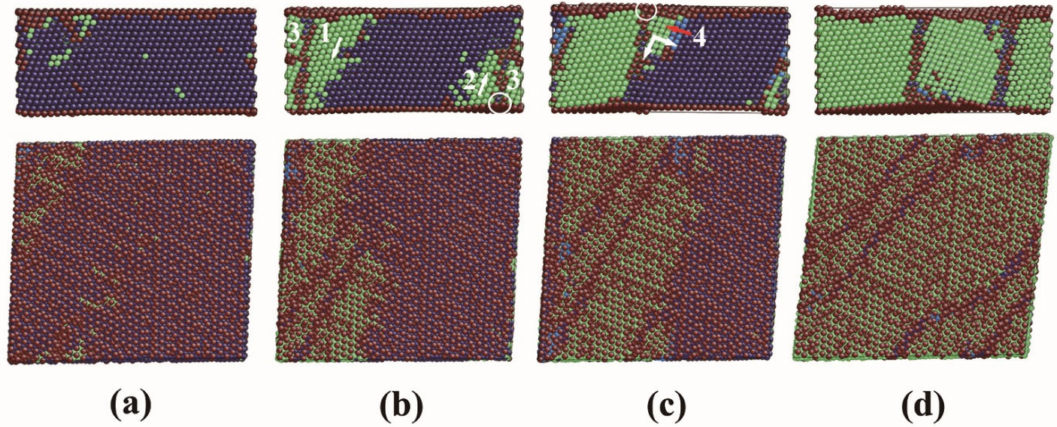
Figure 5. Snapshots of the ongoing martensitic phase transition in film 1 at 300 K. The colors denote Table 1. 0) fcc plane and the lower figures demonstrate the upper original (111) fcc surface. The numbers indicate the bcc phases nucleated at di ff erent positions. ( a ) Status at a shear angle of 1.5 ◦ . Bcc1 nucleates at the upper free surface; ( b ) Status at a shear angle of 2.8 ◦ . Bcc3 is di ff erently orientated compared with bcc1 and bcc2. The white arrows indicate the growth directions of bcc1 and bcc2; the white circle indicates a kink at the free surface; ( c ) Status at a shear angle of 4 ◦ . Bcc1 nucleated at the upper surface grows, while bcc4 with di ff erent crystalline orientation nucleates at the intersection between the phase boundary and free surface. The white arrow indicates the growth direction of bcc4; ( d ) Status at a shear angle of 10 ◦ . The martensitic phase transition